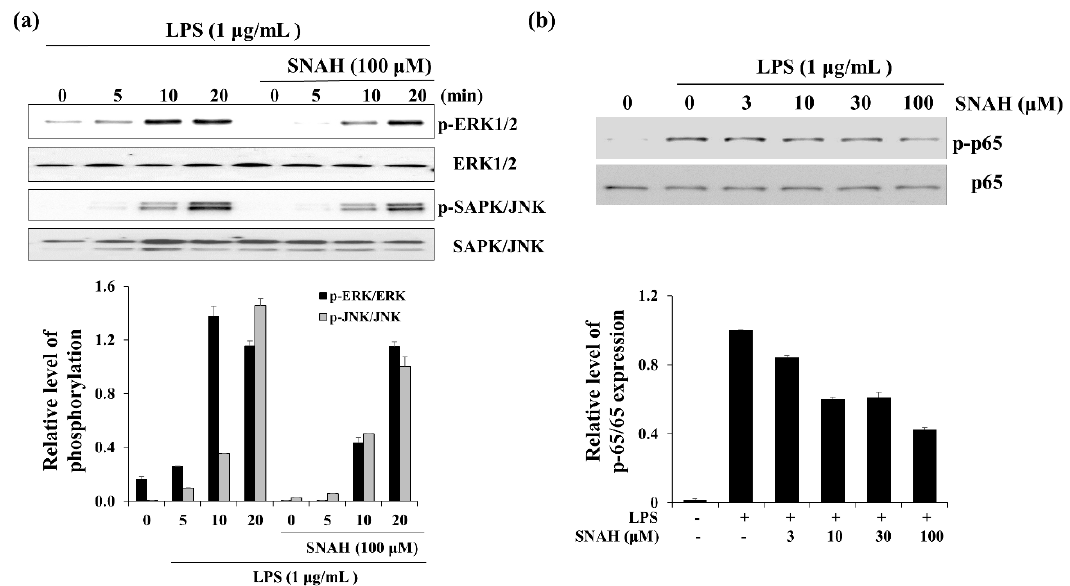
Figure 6. Effect of SNAH on MAPK and p65 signaling pathways. ( a ) The time course of ERK (extracellular-signal-regulated kinase) and SAPK / JNK (Stress-activated protein kinase / Jun-amino- terminal kinase) phosphorylation stimulated by LPS in RAW264.7 cells. ( b ) RAW 264.7 cells were treated for 15 min with LPS (1 µ g / mL) alone or with LPS (1 µ g / mL) coupled with 3–100 µ M SNAH. Cell lysates were prepared and blotted with the indicated anti-phospho-antibodies. Total ERK1 / 2, SAPK / JNK, and NF- κ B (p65) were probed as quantitative controls.